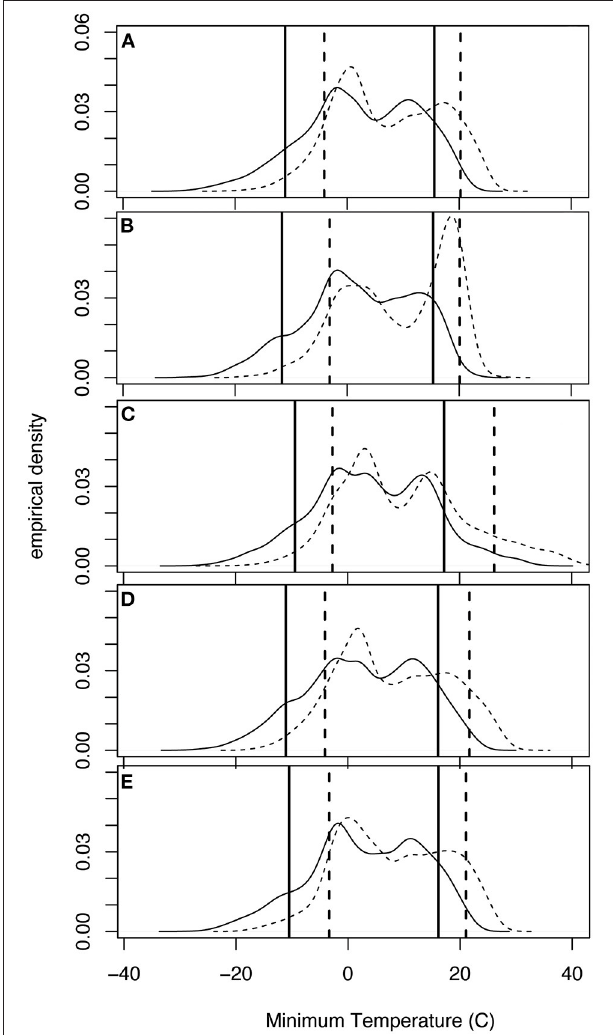
FIGURE 9 | Daily maximum temperature empirical density functions. The solid black line is the historic bias corrected data and the dashed line represents the future bias corrected data at each location. The solid vertical lines represent the 10 and 90% values at location (A) 200146 (Gratiot, IV), (B) 202423 (Oscoda, I), (C) 205434 (Midland, II), (D) 205662 (Mount Pleasant, III) and (E) 206300 (Owosso, V).